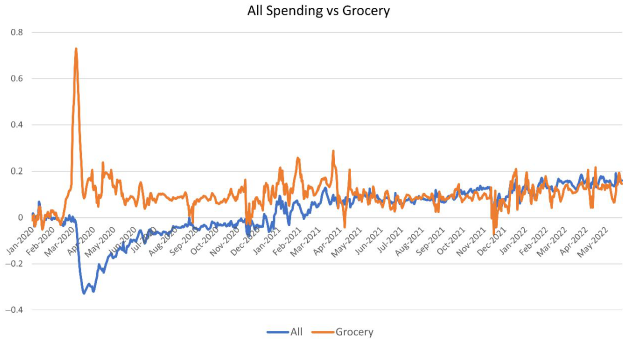
Figure 2. The USA consumption over the past two